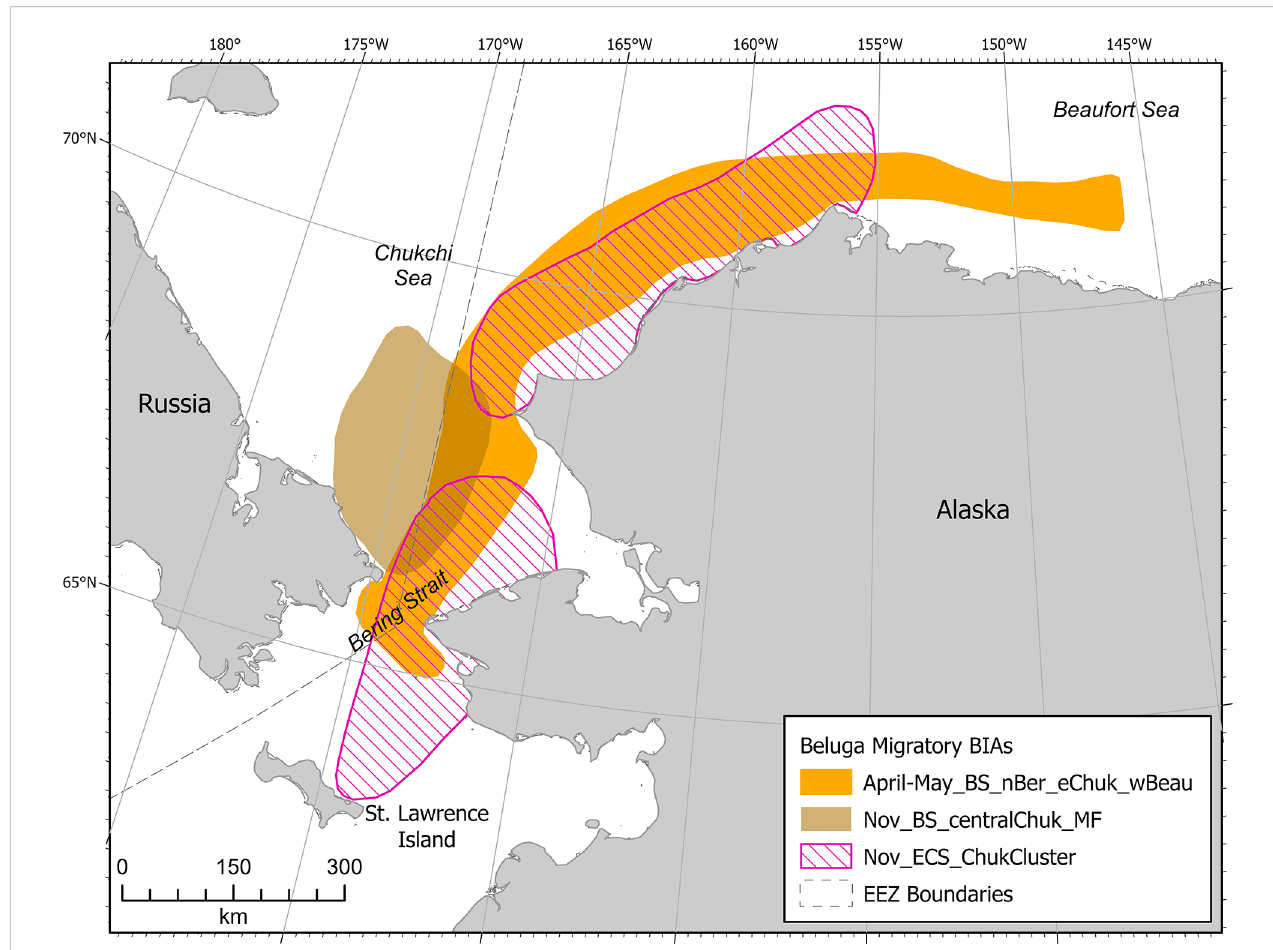
FIGURE 13 Arctic region beluga (Eastern Chukchi Sea Stock and Beaufort Sea Stock) migratory